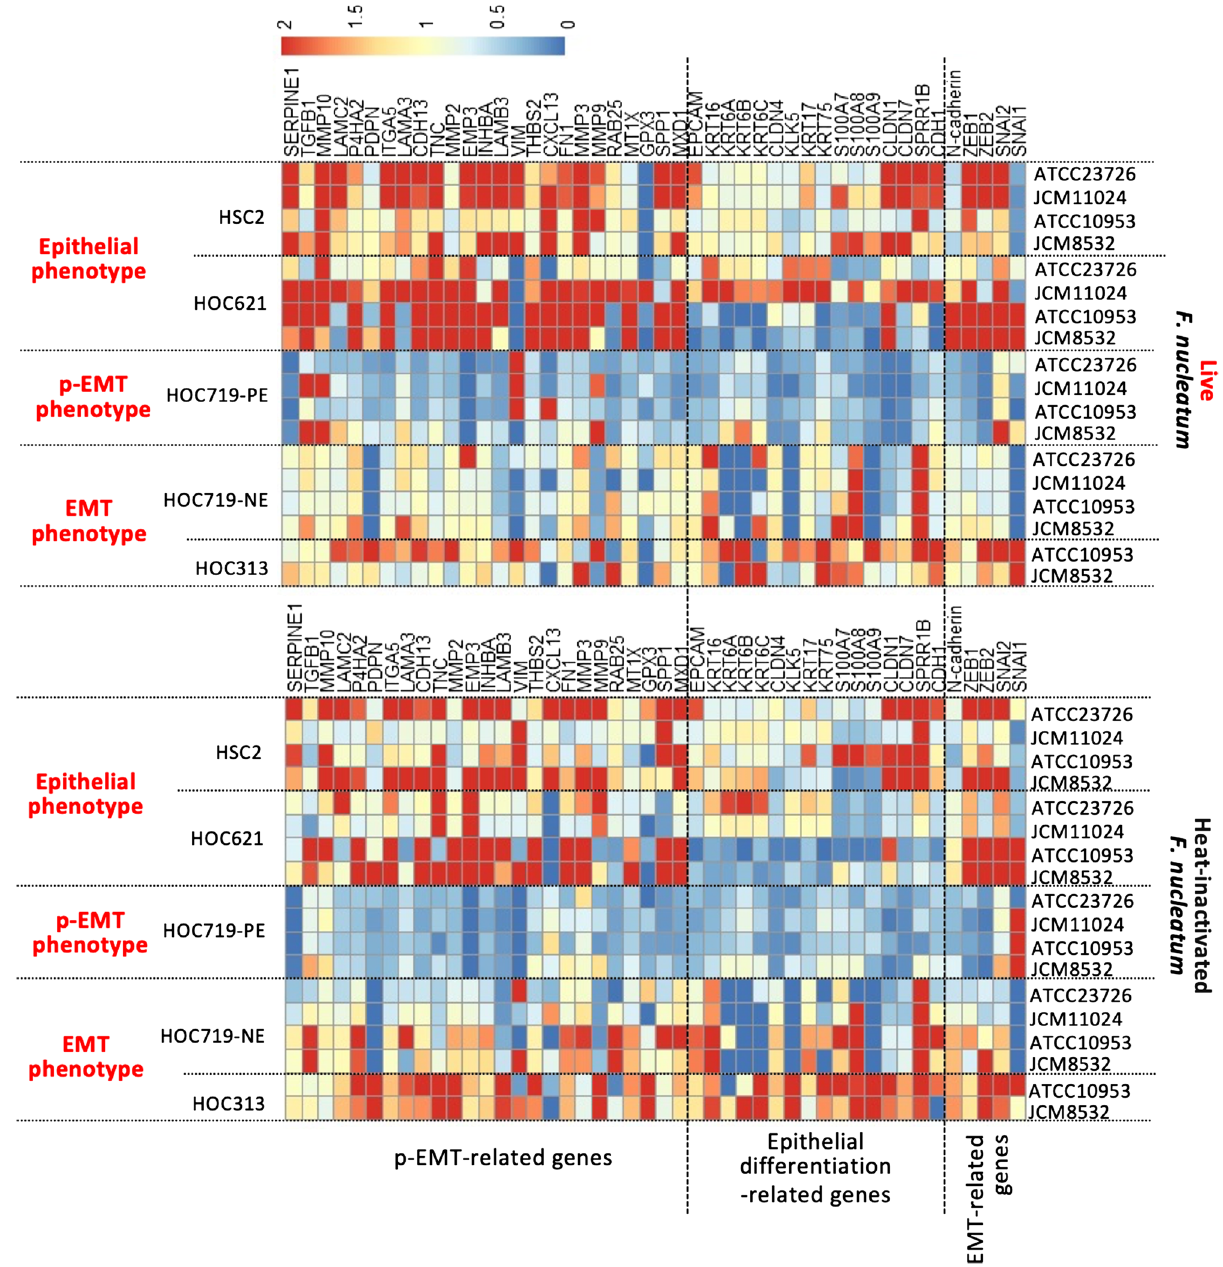
Figure 6. Heatmap of gene expression by co-culture with live or heat-inactivated F. nucleatum in OSCC cells. Heatmap shows live or heat-inactivated F. nucleatum (JCM8532, ATCC10953, JCM11024, and ATCC23726) in OSCC with epithelial (HOC621 and HSC2), p-EMT (HOC719-PE), and EMT phenotype (HOC313 and HOC719-NE). Gene expression data is shown in Fig. 4 (HOC313 and HOC621), Fig. 5 (HOC313 and HOC621), Supplementary Fig. S2 (HOC621), Supplementary Fig. S3 (HOC719-NE), Supplementary Fig. S4 (HSC2), and Supplementary Fig. S5